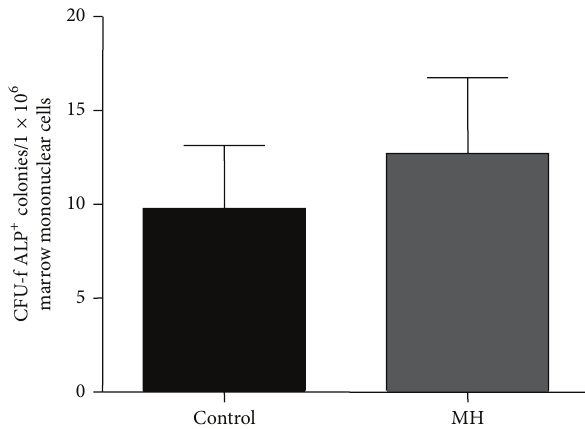
Figure 7: Effects of MH on the osteoprogenitor cell pool in bone marrow of fetal guinea pigs. Data showing the number of CFU- f colonies stained positive for alkaline phosphatase (ALP) in total bone marrow mononuclear cell population (values are means ± SEM, 𝑛 = 5